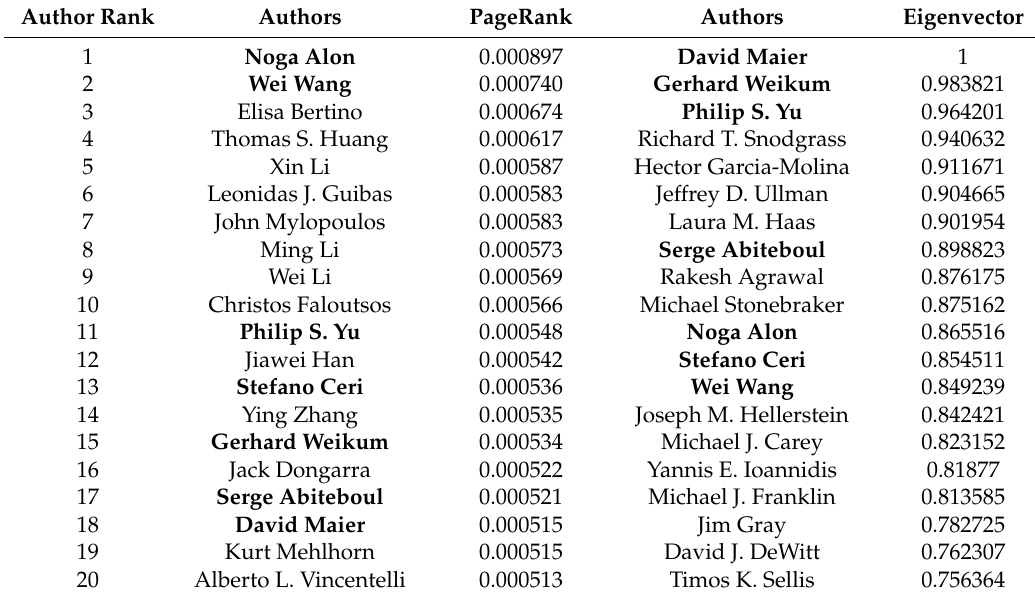
Table 5. Top 20 authors based on prestige measures.